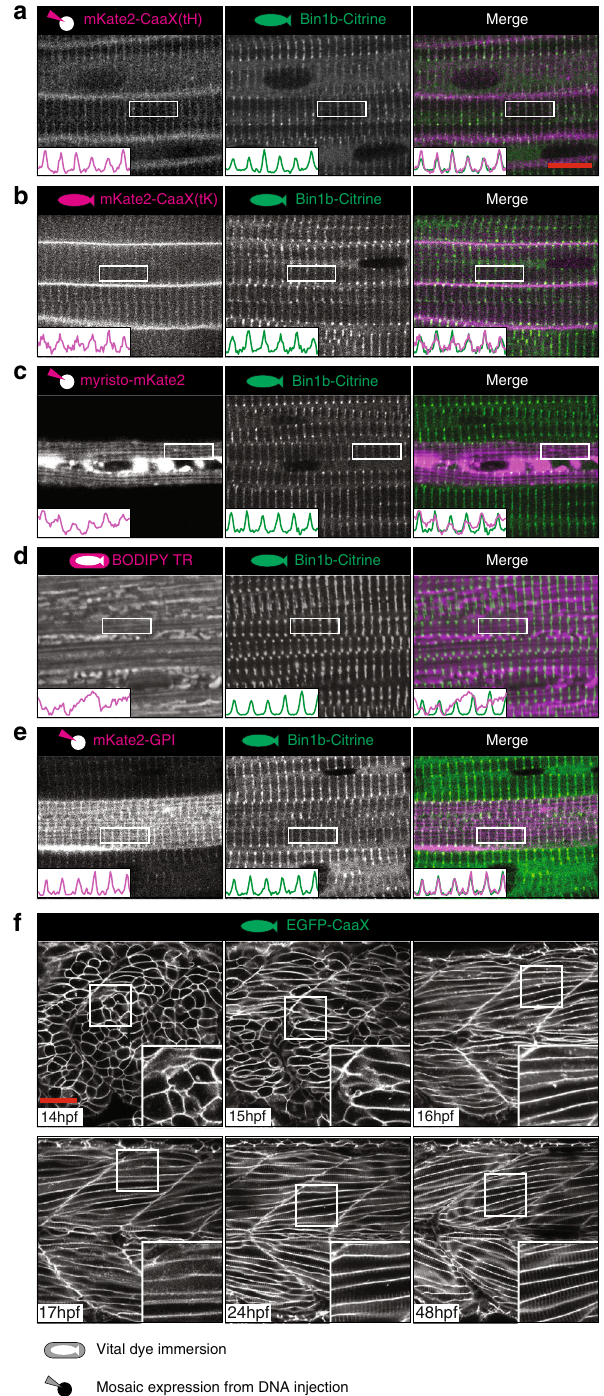
Fig. 1 An in vivo system for T-tubule development. a – e The CaaX domain from Hras marks both sarcolemma and T-tubule. Markers were screened at 48 hpf for T-tubule speci fi city on a stable transgenic background expressing Bin1b-Citrine from the endogenous locus. a CaaX domain from Hras (tH). b CaaX domain from Kras (tK). c Myristoylation domain from ARF5. d BODIPY-TR vital dye. e GPI anchor from zebra fi sh folate receptor gamma. f Time course of tubule formation using stable EGFP-CaaX background. All images are representative of 12 individual cells within different individual animals. See also Supplementary Movies 1 and 2. Scale bars; ( a – e ) 10 µ m, ( f ) 50 μ